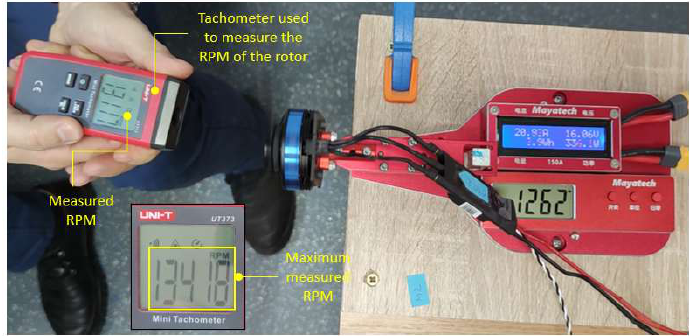
Figure 13. Measurement of the rotor assembly maximum RPM.